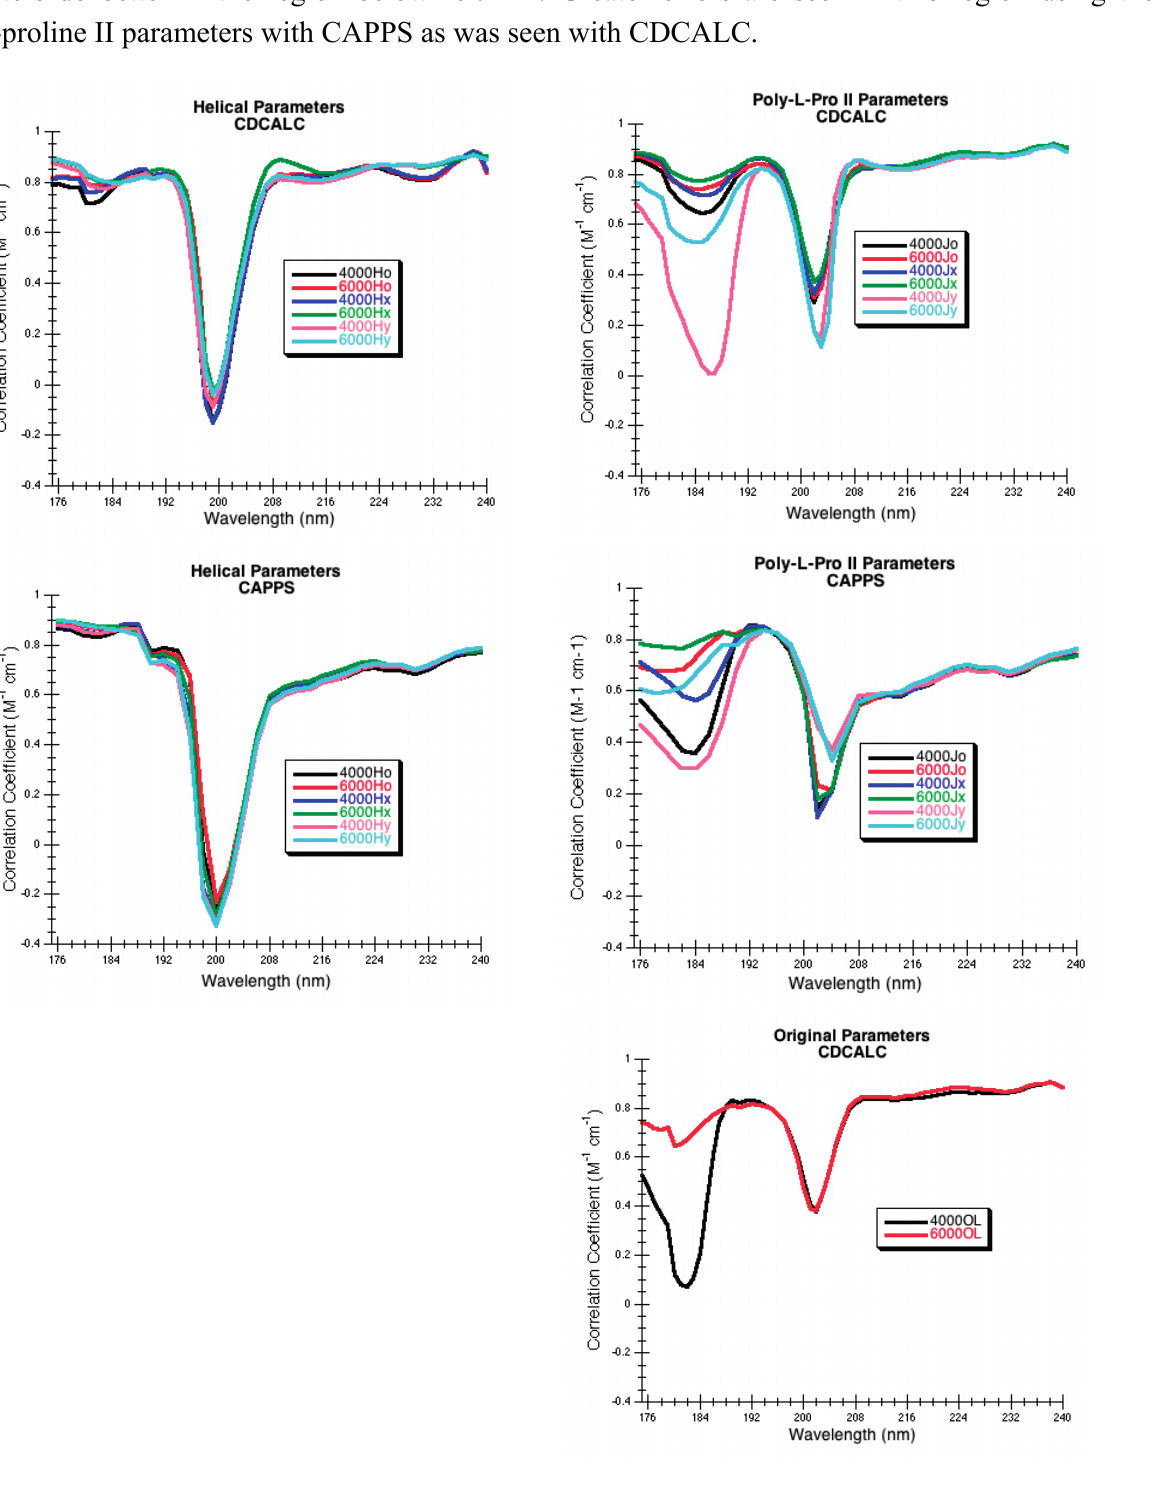
Figure 7. Spearman Rank Correlation Coefficients for DInaMo Calculations. CDCALC on 24 proteins. CAPPS on 17